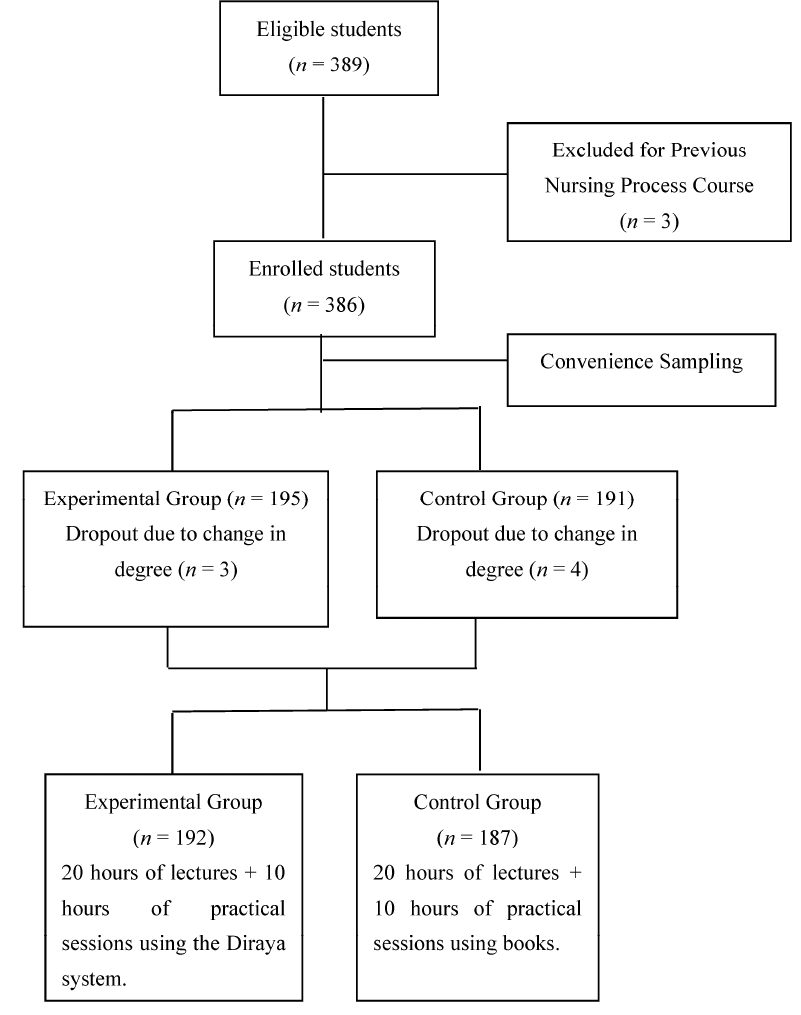
Figure 1. Flow of